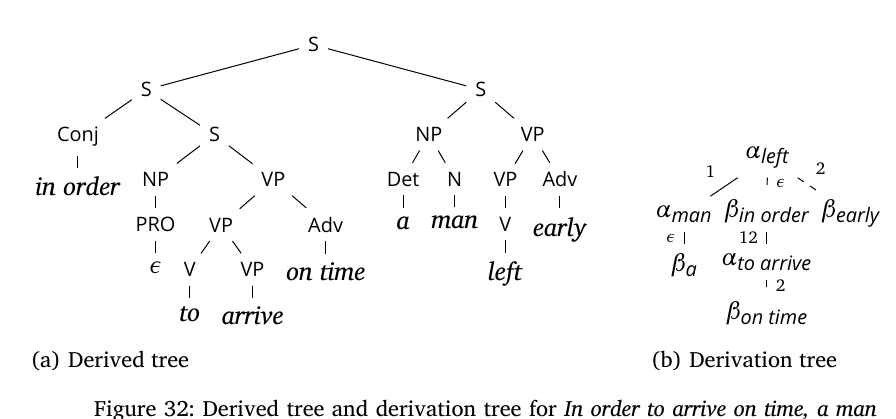
= C ( C ( C to arrive C on time in order left I S 32 ) = c ( c ( c to arrive c on time in order left I S 32 ) 32